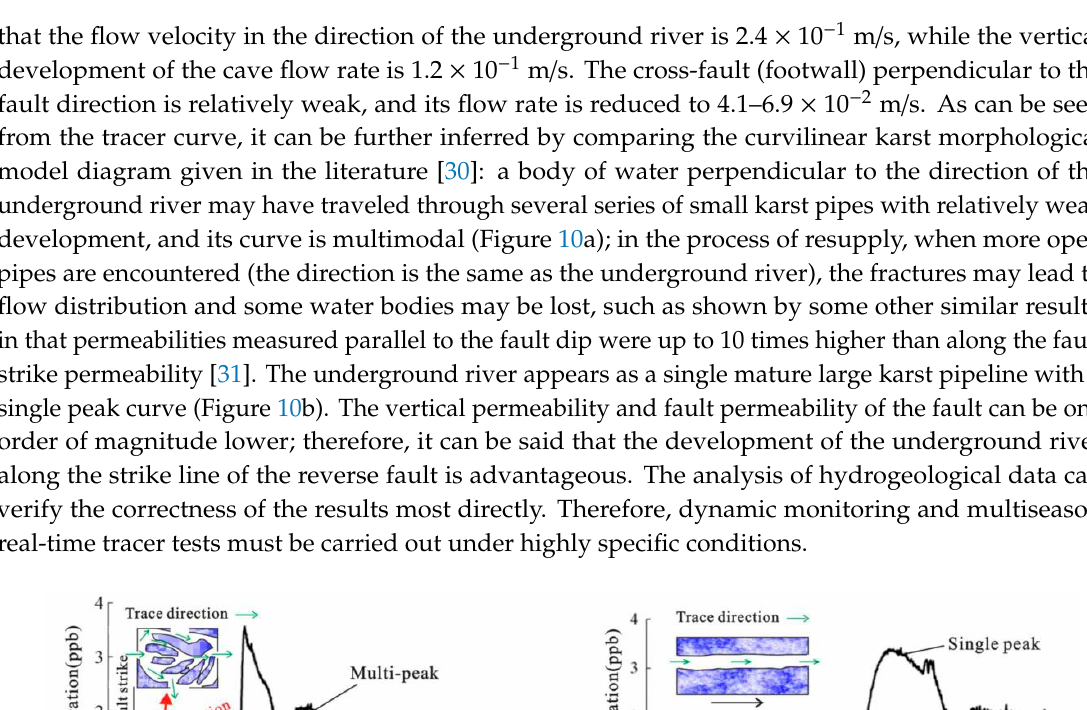
Table 2. The zoning characteristics of the fault structure with the change of depth.